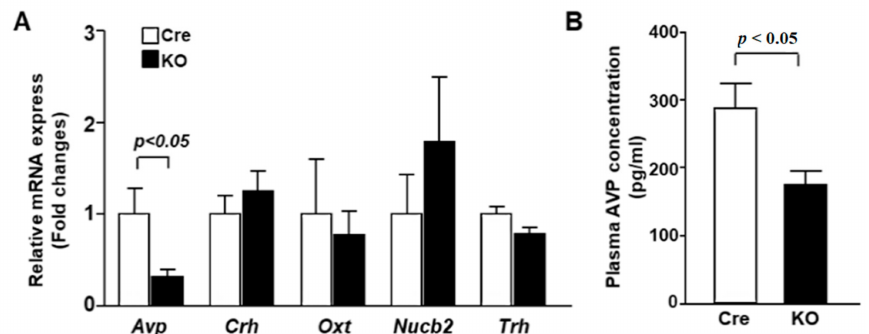
Figure 2. AVP mRNA expression in the PVN and plasma AVP concentration were decreased in KO mice. ( A ) The PVN of Cre mice and KO mice at 12 weeks of age was isolated at ZT1 for mRNA isolation ( n = 6 for each group). The mRNA levels of Avp , Crh , Oxt , Nucb2 and Trh were measured by RT-PCR and expressed as values relative to the expression of Cre mice, which is arbitrarily defined as 1. ( B ) Plasma AVP concentrations at ZT1 in Cre and KO mice at 12 weeks of age ( n = 6 for each group). Data are presented as mean ± SEM. Cre vs. KO determined by one-way ANOVA followed by the Bonferroni